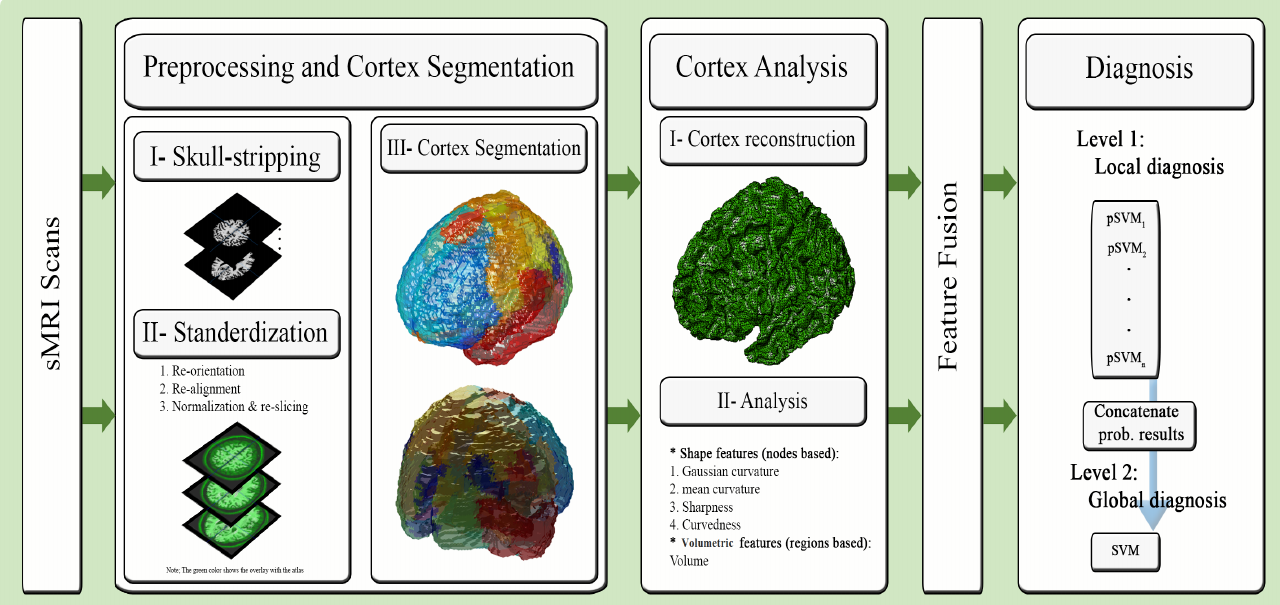
Figure 1. The proposed cortical region-based diagnostic system of cognitive impairment using